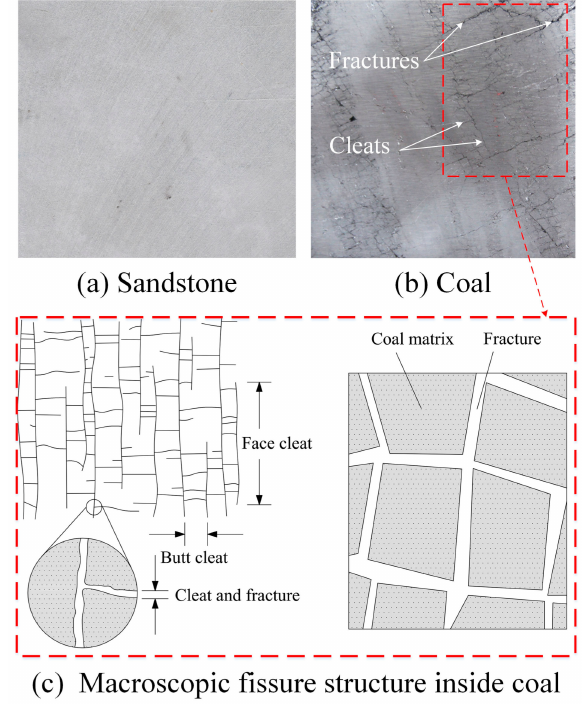
Figure 15. Schematic diagram of cleats and fracture structure in coal and rock